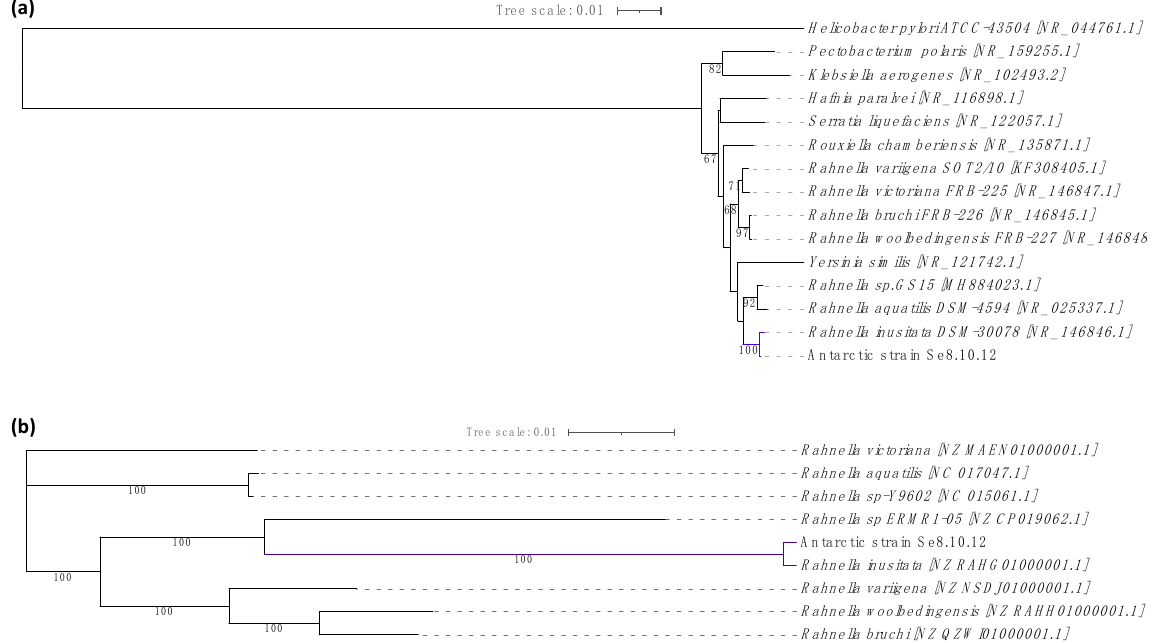
Figure 4. Evolutionary history construction of the Antarctic strain Se.8.10.12 based on phylogeny. ( a ) Phylogenetic analysis of the 16S rRNA gene constructed with Bio-NJ method based on the Kimura two-parameter distance estimation model ( Helicobacter pylori was used as an outgroup). ( b ) Maximum likelihood phylogenetic analysis of core-proteome based on the concatenated amino acid sequences of orthologous genes present in all Rahnella species using RAxML. GenBank accession numbers are provided in brackets. Branch lengths represent the number of substitutions per site (Bar: 0.01 substitutions per site), and bootstrap percentages of 1000 replicates are shown in the branches.